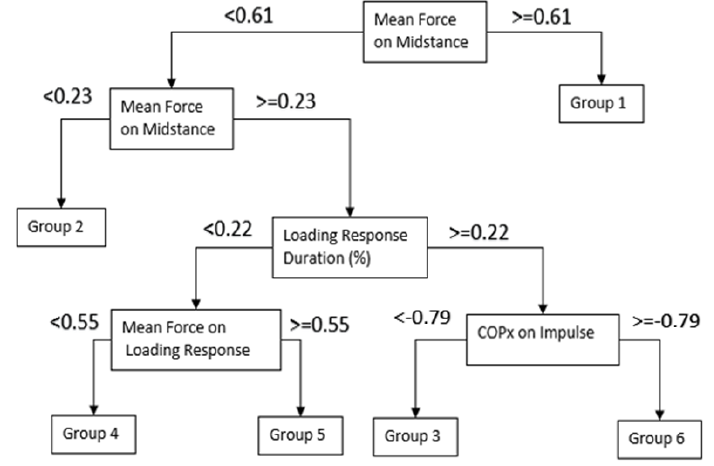
Figure 8. A flowchart of the decision-making structure extracted from CART after the pruning and exclusion of Group 7. Values of force and duration were normalized between 0 and 1, and values of COPx were normalized between − 1 and